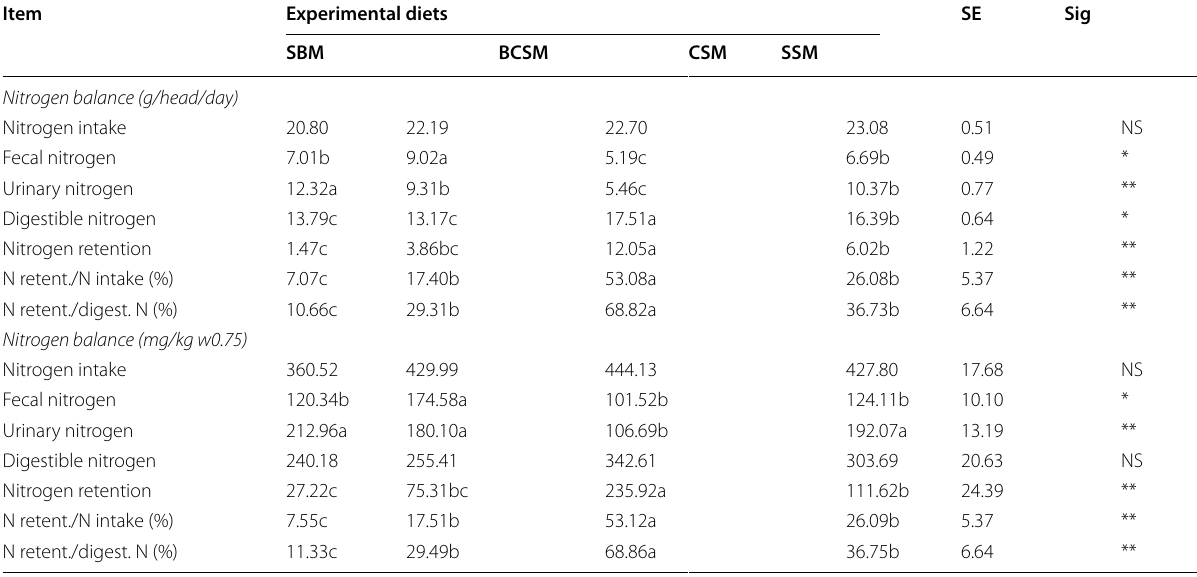
a, b and c: Means in the same row with different superscripts are significantly different at ( p < 0.01) SE, standard error; NS, nonsignificant difference *Significant difference at ( p < 0.05), ** Significant difference at ( p <